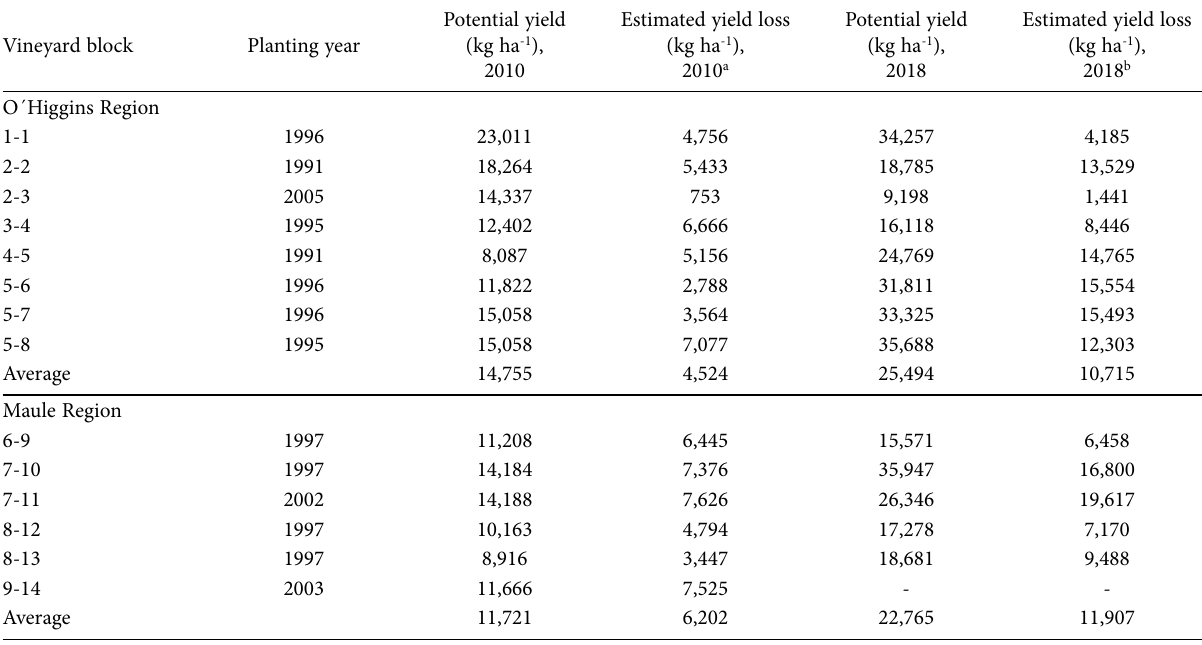
Table 4. Estimated yield losses in ‘Cabernet Sauvignon’ vineyards, sampled in two years (2010 and 2018) in O’Higgins and Maule Regions, Central Chile.